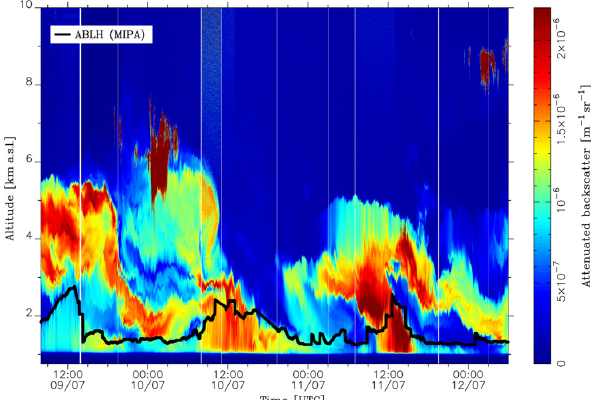
Figure 2. High-resolution time series of the total attenuated backscatter at 1064nm measured over Potenza during the EAR- LINET 72h exercise (9–12 July 2012). Time resolution is 60s, ver- tical resolution is 3.75m. The black curve shows the ABLH as re- trieved by the proposed MIPA